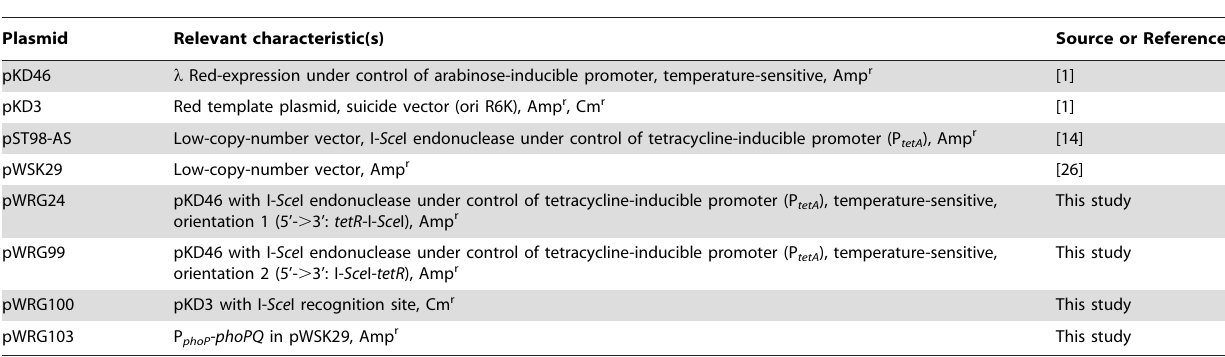
Table 4. Plasmids used in this study.